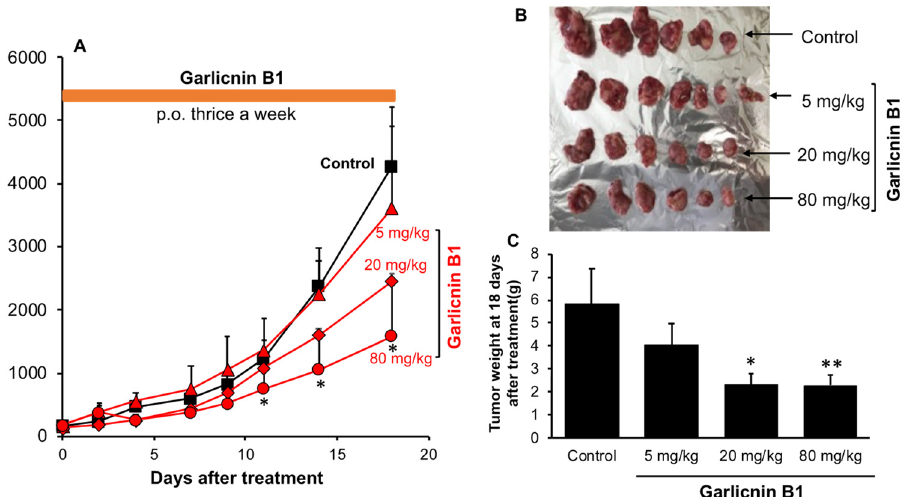
Figure 6. Anti-tumor effect of garlicnin B1 against mouse sarcoma S180 solid tumor. Garlicnin B1 treatment was initiated on day 7 after S180 tumor cell inoculation when tumors had grown to 7–8 mm in diameter. ( A ) shows the changes in tumor volume during the experiment, ( B ) shows representative pictures of tumors collected on day 18 after garlicnin B1 treatment, and ( C ) shows the average tumor weight of collected tumors. Data are presented as means ± standard deviation (SD); n = 4–8. * p < 0.05; ** p < 0.01 versus the untreated control group. See text for details.